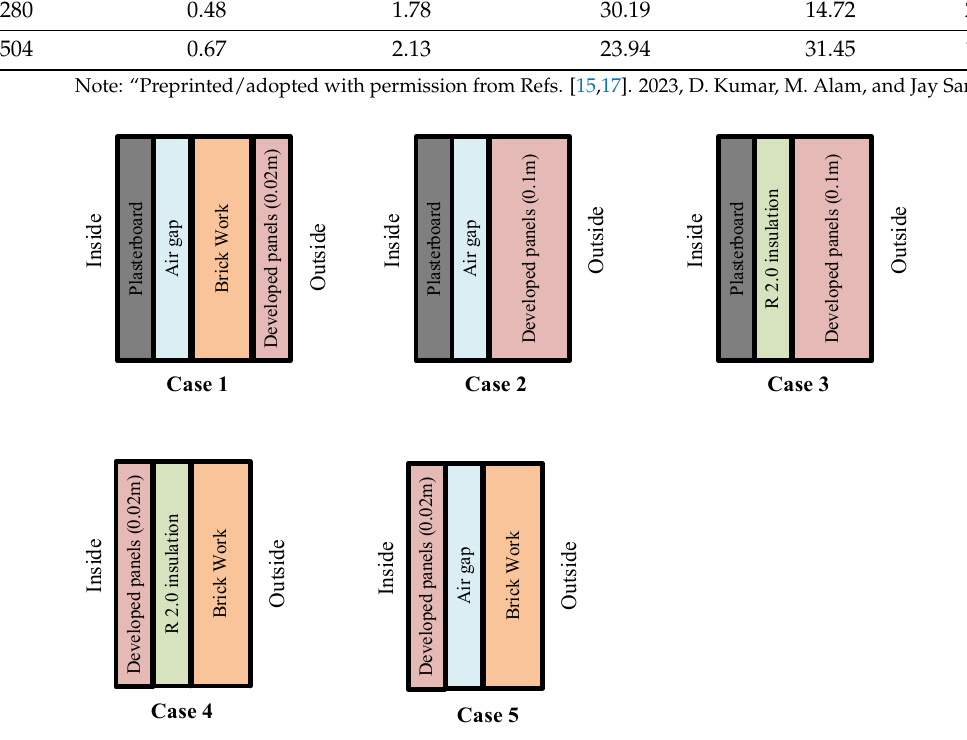
Figure 5. Schematic view of building external wall for different simulated cases.